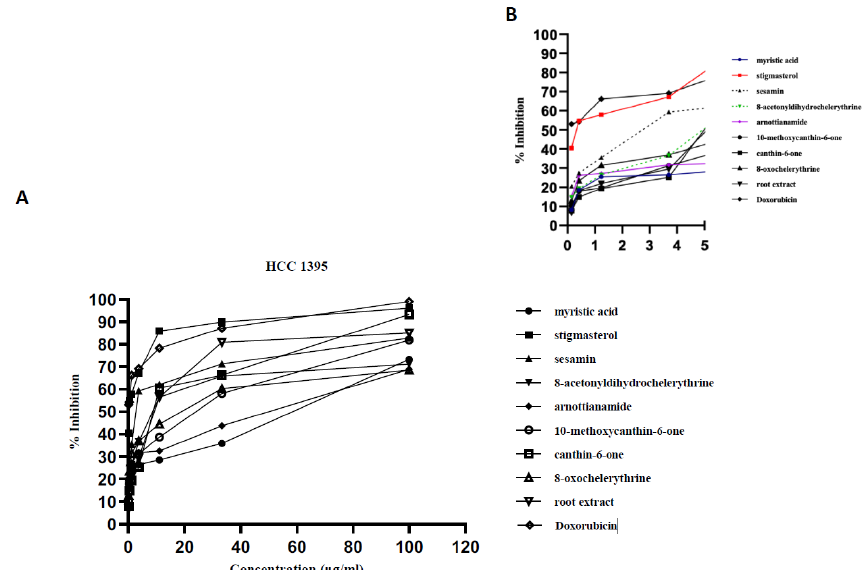
Figure 2. Antiproliferative activity of the tested samples against the human breast cancer cell line (HCC1395). Antiproliferative activity of the tested samples against various cancer cell lines recoded as % growth inhibition. (A) Biphasic growth curve of dose-dependent anti-proliferation effects: 0–100 µg/mL. (B) Effect of test samples at low concentrations: 0–5 µg/mL.